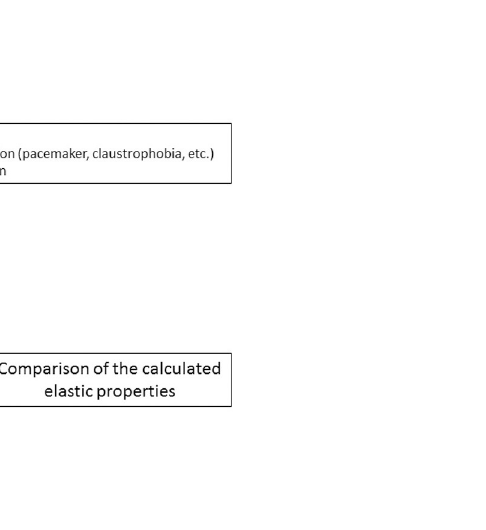
Fig 1. Flow chart of the study design.